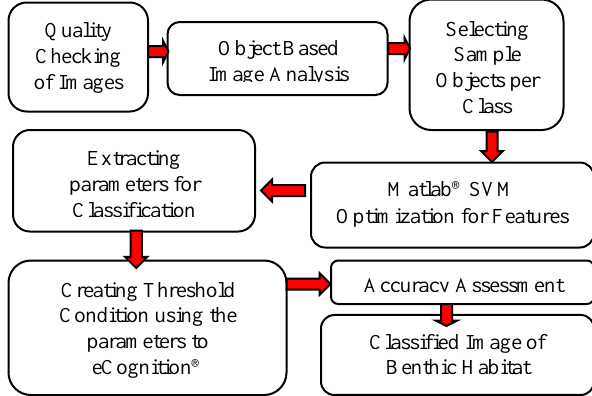
Figure 2. Processing diagram for creating benthic habitat